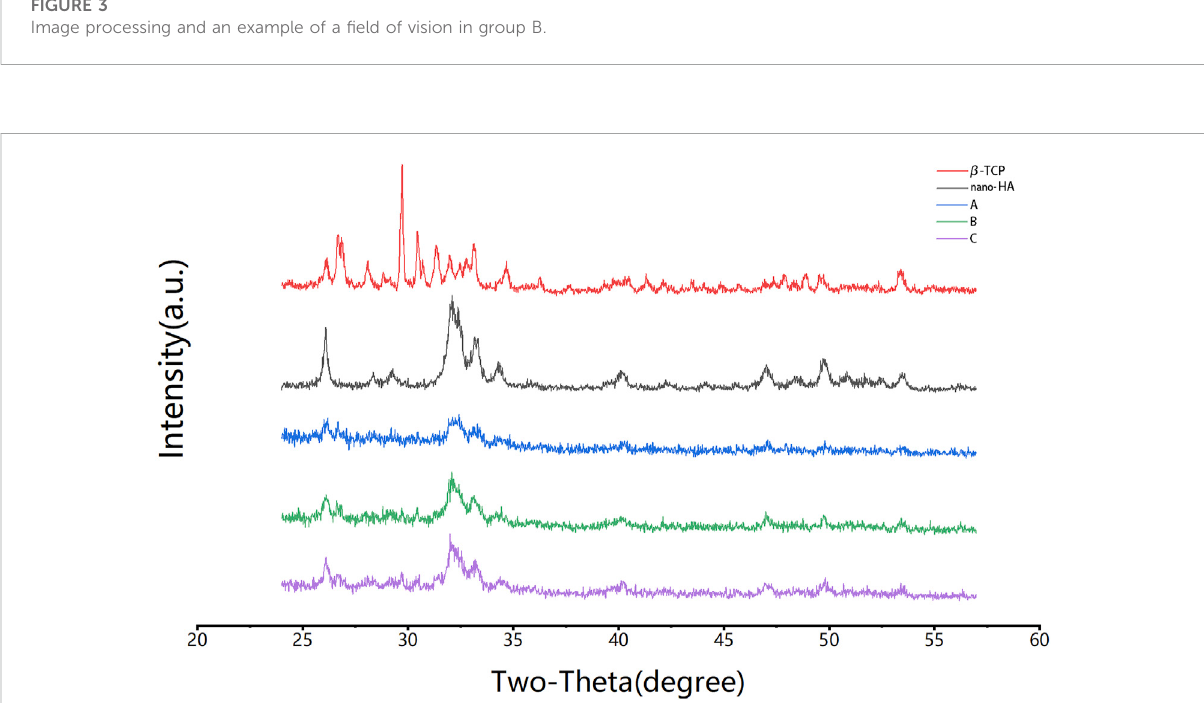
FIGURE 4 XRD analysis of the formulations. Group B and group C had diffraction peaks at 26 ° , 29 ° , 32 ° , and 33 ° 2 θ , which were related to nano-HA and β - TCP, and were not observed in group A. The crystalline phases of nano-HA and β -TCP were